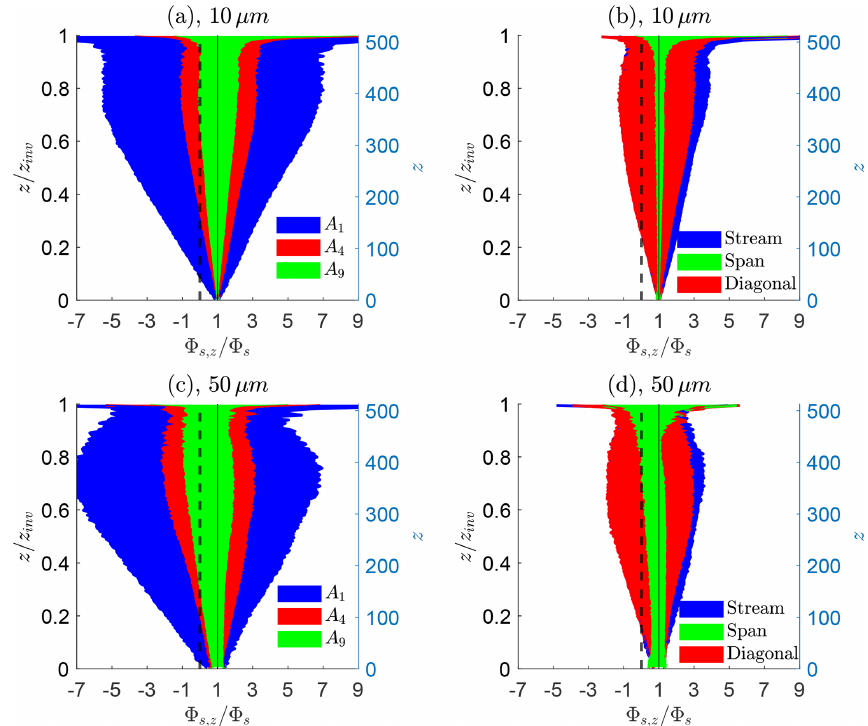
Figure 9. Inferred effective surface fluxes (cid:56) s,z normalized by the true effective surface flux (cid:56) s as a function of sampling height for 10µm (a, b) and 50µm (c, d) aerosol particles. Elevated fluxes are used to infer surface fluxes via linear extrapolation. The left panels (a, c) illustrate variability due to area coverage, and the right panels (b, d) illustrate directional sampling for the same total area A 4